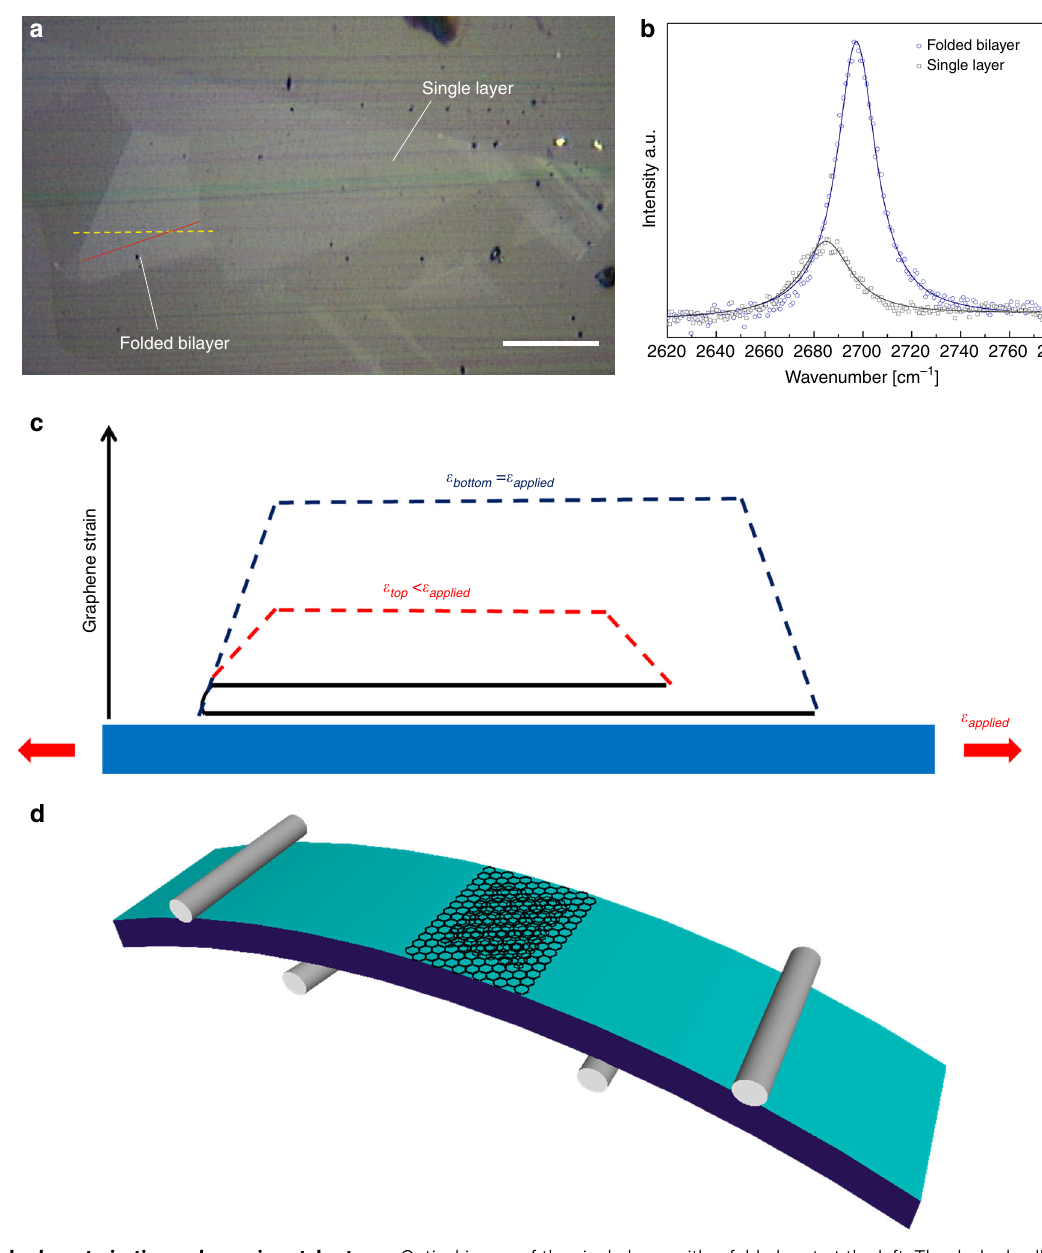
Fig. 1 Sample characterization and experimental setup. a Optical image of the single layer with a folded part at the left. The dashed yellow line indicates the scan line, and the red line marks the presence of a wrinkle (see the AFM image in Supplementary Fig. 1). The scale bar is 20 microns. b Spectra of the 2D peak of the single and folded areas. c Schematic representation of the stress transfer mechanism from the polymer to the bottom layer and from the bottom layer to the top. d Schematic of the experimental setup is shown with two single-layer graphenes stacked in an incommensurate